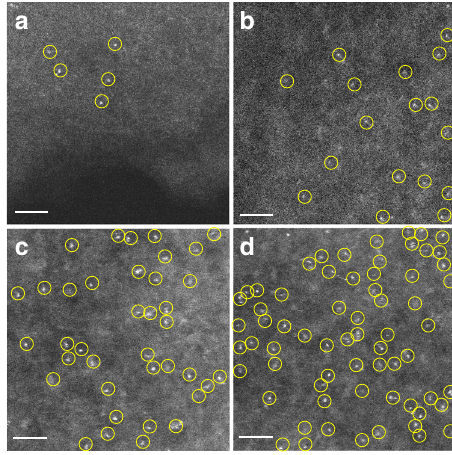
Fig. 3 AC HAADF-STEM images of Pt SACs with different atom densities.